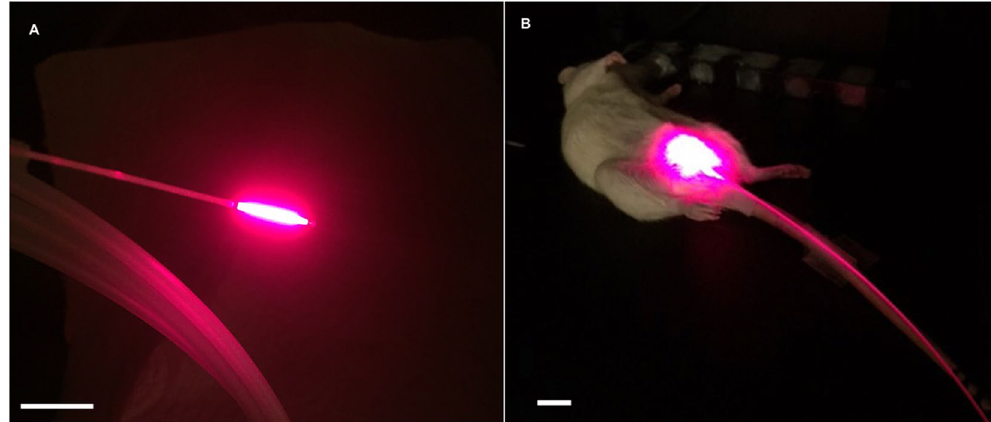
Figure 1. Intravesicular light delivery. Photographs of fiber optic diffusing tip ( A ) and female rat with fiber optic inserted in bladder ( B